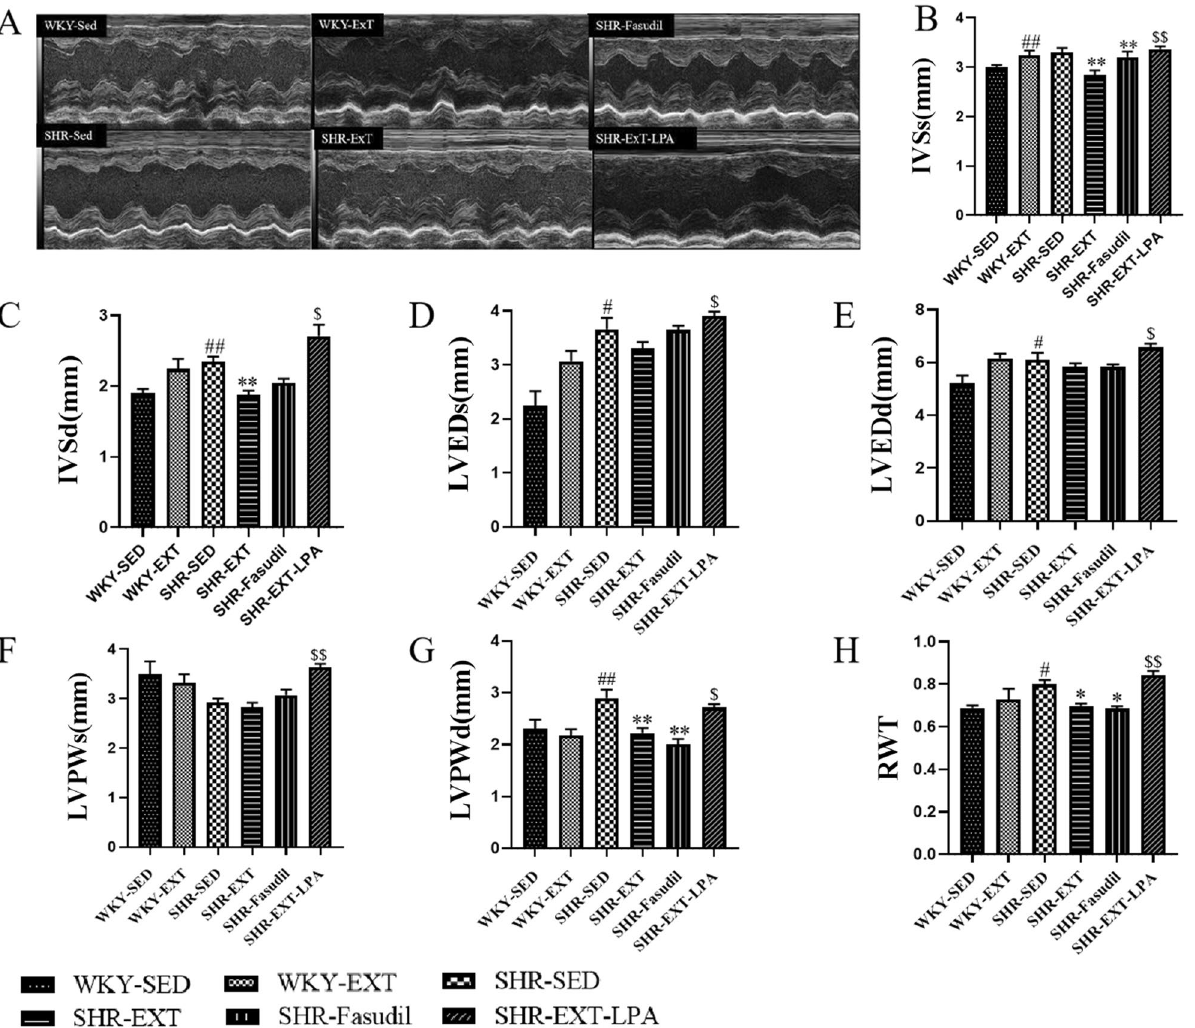
Figure 3. Effect of exercise training on left ventricular function and wall thickness. ( A ) The original ultrasound image. ( B ) IVSs (Systolic interventricular septal); ( C ) IVSd (diastolic interventricular septal); ( D ) LVEDs (left ventricular end-systolic dimension); ( E ) LVEDd (left ventricular end-diastolic dimension); ( F ) LVPWs (left ventricular posterior wall during systole); ( G ) LVPWd (left ventricular posterior wall in diastole); ( H ) RWT (relative wall thickness). SHR-Sed SHR control group, WKY-Sed WKY control group, SHR-ExT SHR exercise group, WKY-ExT WKY exercise group, SHR-ExT-LPA SHR exercise plus LPA group; SHR-Fasudil SHR plus Fasudil group; Data are expressed as mean ± SEM. n = 7 in each group. # P < 0.05, ## P < 0.01 vs WKY-Sed; $ P < 0.05, $$ P < 0.01 vs SHR-ExT; * P < 0.05, ** P < 0.01 vs